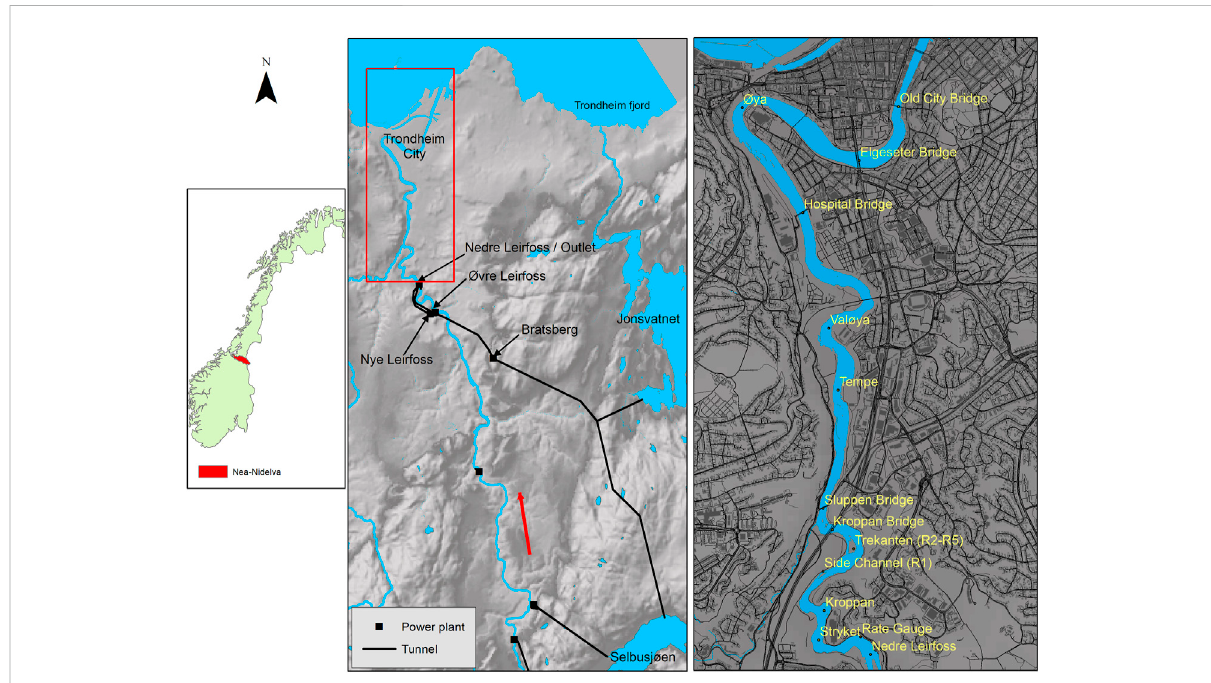
FIGURE 1 OverviewofNidelva.Leftpanel:theNea-NidelvacatchmentinNorway;middlepanel:theNidelvahydropowersystemwithSelbusjøenreservoir andBratsbergandthepower plants atØvre andNedreLeirfossmarked. Right panel: detailsofRiverNidelva downstreamofthepower plantoutlet in Nedre